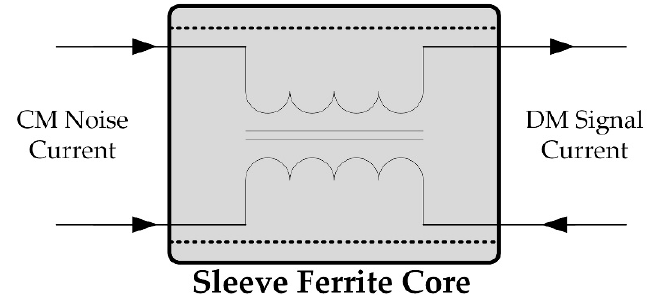
Figure 1. Diagram of common mode (CM) and differential mode (DM) currents passing through a ferrite core.